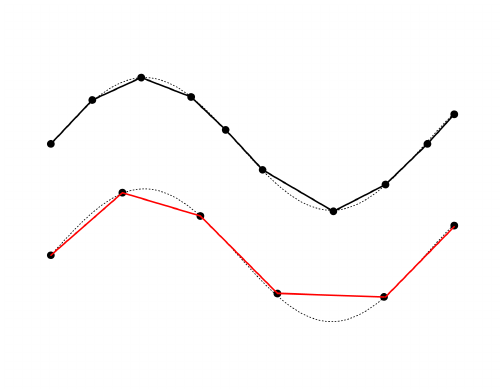
Figure 17. A pair of asynchronously sampled trajectories.